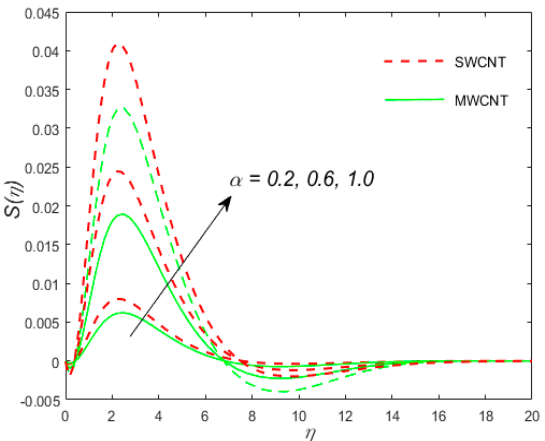
Figure 13. The variation of the micro rotation profile S ( η ) for the case of SWCNT and MWCNT versus the similarity variable for the distinct values of the vortex velocity or material parameter γ *.